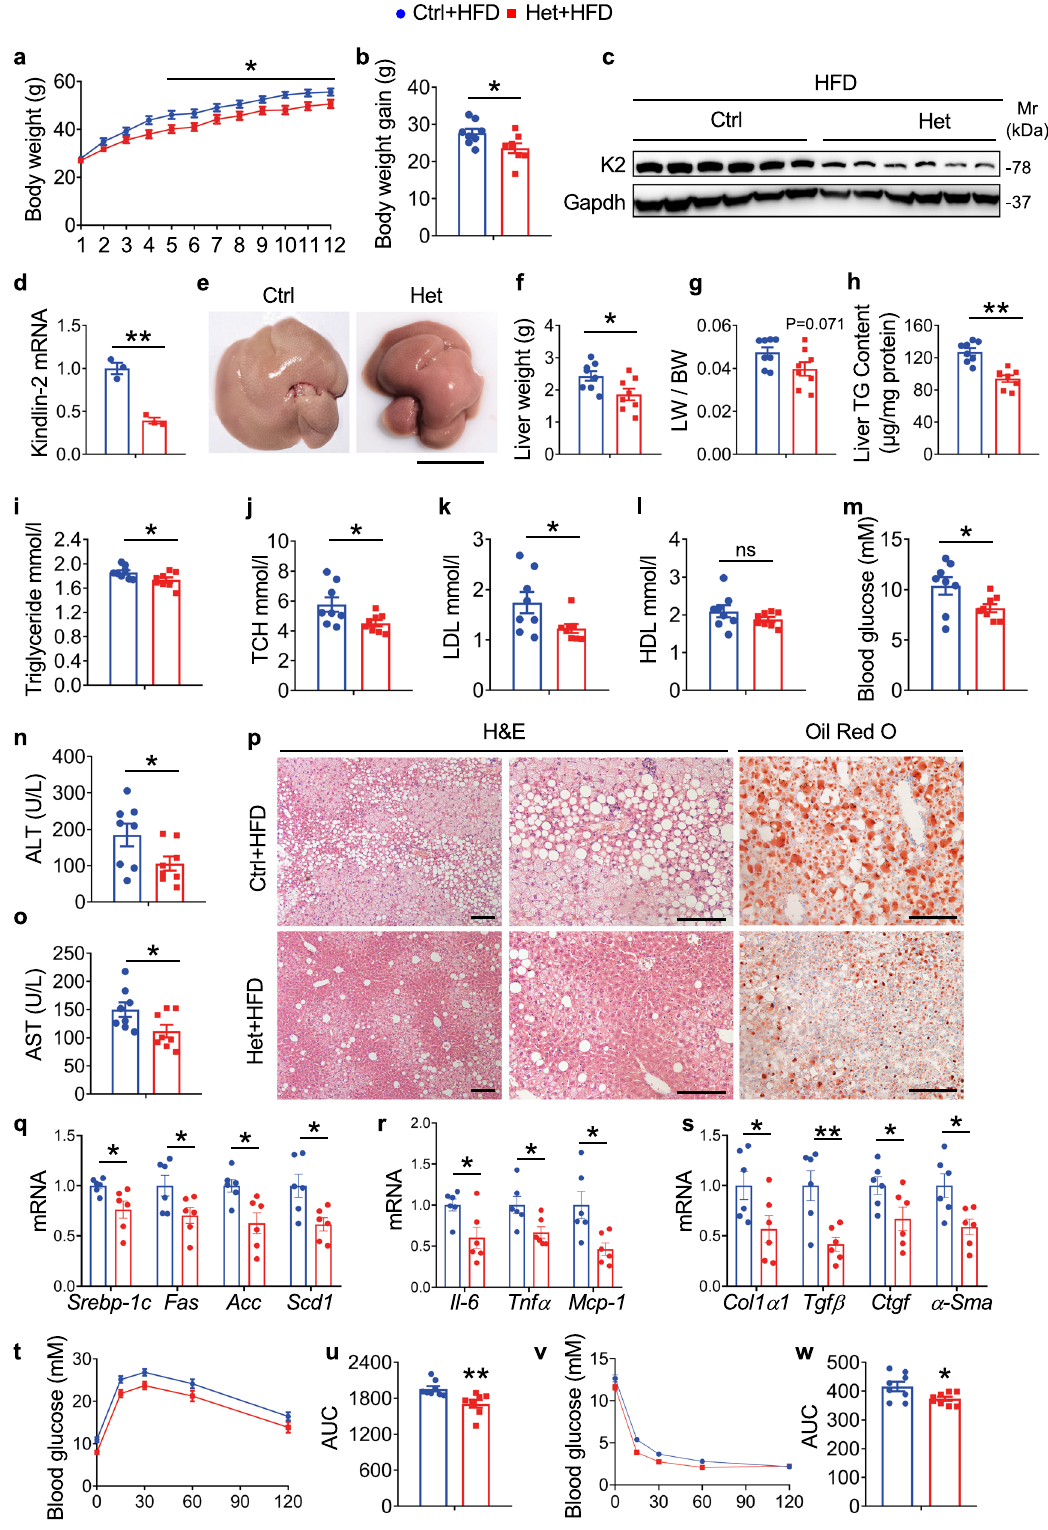
assays using protein extracts from livers of db / db and HFD-fed mice (Fig. 6f). We next generated a series of Kindlin-2 deletion plasmid constructs as indicated (Fig. 6g) to de fi ne regions within the Kindlin- 2 molecule that are essential for its interaction with Foxo1 protein. These deletion plasmids and V5-Foxo1 were co-transfected into HEK293T cells, followed by IP assays. The results showed